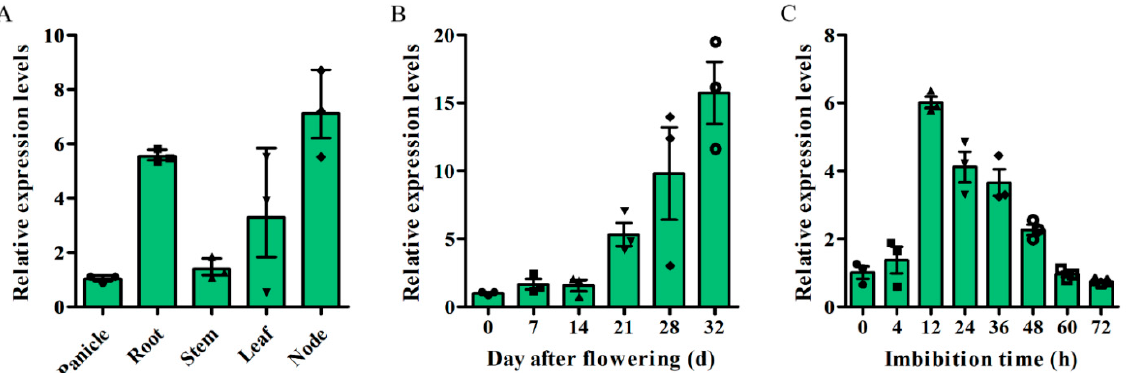
Figure 2. Expression patterns of OsSAUR33 by quantitative reverse transcription polymerase chain reaction (qRT-PCR) in rice. ( A ) Expression pattern of OsSAUR33 in various tissues, including panicle, root, stem, leaf, and internode, of rice. Expression pattern of OsSAUR33 in various developmental stages from 0 to 32 days after flowering ( B ) and during seed germination from 0 to 72 h of imbibition ( C ) in rice. The expression of OsSAUR33 was normalized to that of OsActin . Each column represents the mean ± standard deviation, black small symbol means the value of each replication, n = 3.